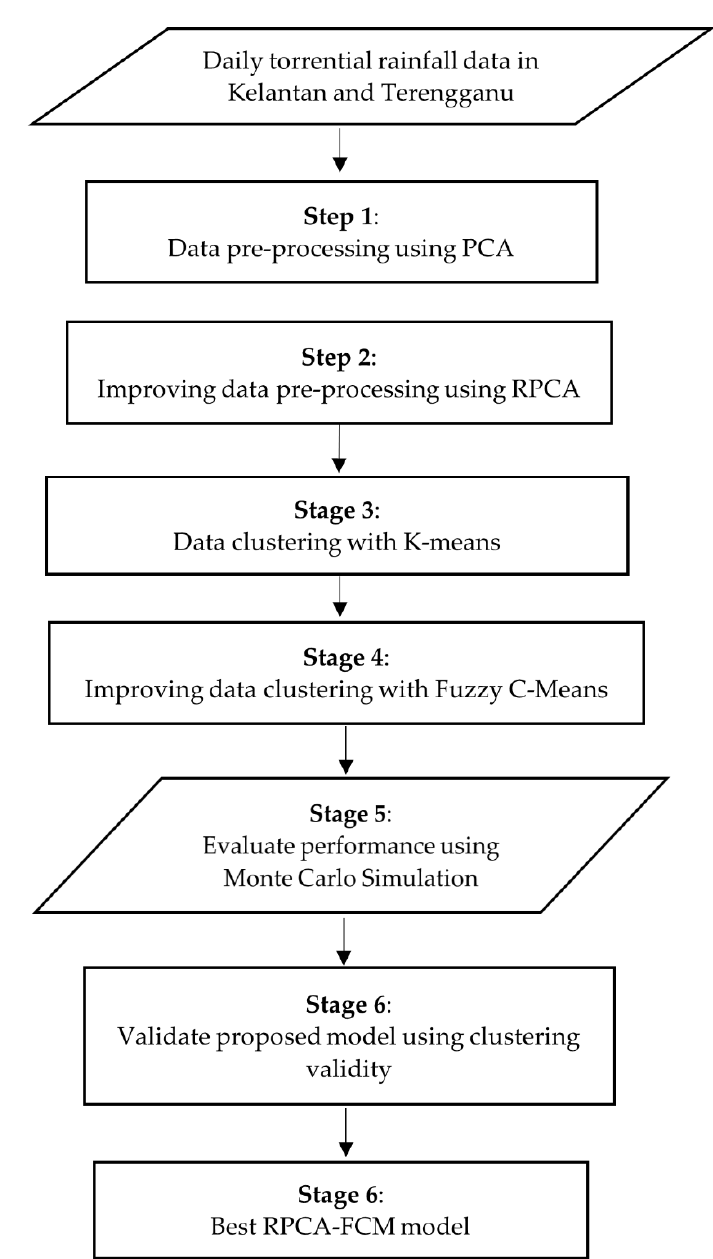
Figure 5. Flowchart of the developed model of RPCA-FCM.